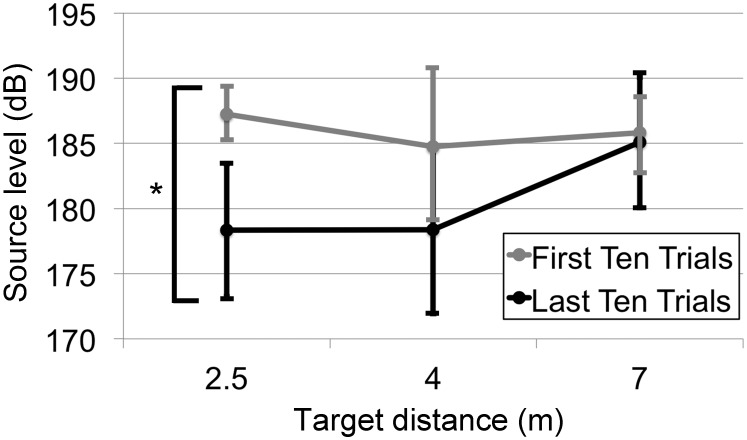
Bootstrapped 95% confidence intervals to demonstrate the effect of learning on initial click source level for the predictable trials.Bootstrapped 95% confidence intervals for the first click between the first ten trials and the last ten trials of each predictable session. Compared to the first ten trials, the dolphin produced significantly (p<0.05) lower source levels for the last ten trials at the 2.5 m distance. The dolphin also produced lower source levels for the last ten trials at the 4 m distance, but due to the large variation this change was not significant (p>0.05).